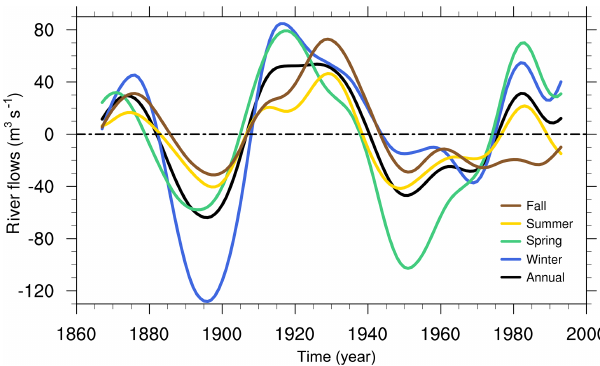
Figure 7. Low-pass-filtered interannual anomalies of the Seine river flows at the Poses station in the reconstruction. Black: annual; blue: winter; green: spring; yellow: summer; and brown: fall. The annual mean over the whole period is 446m 3 s − 1